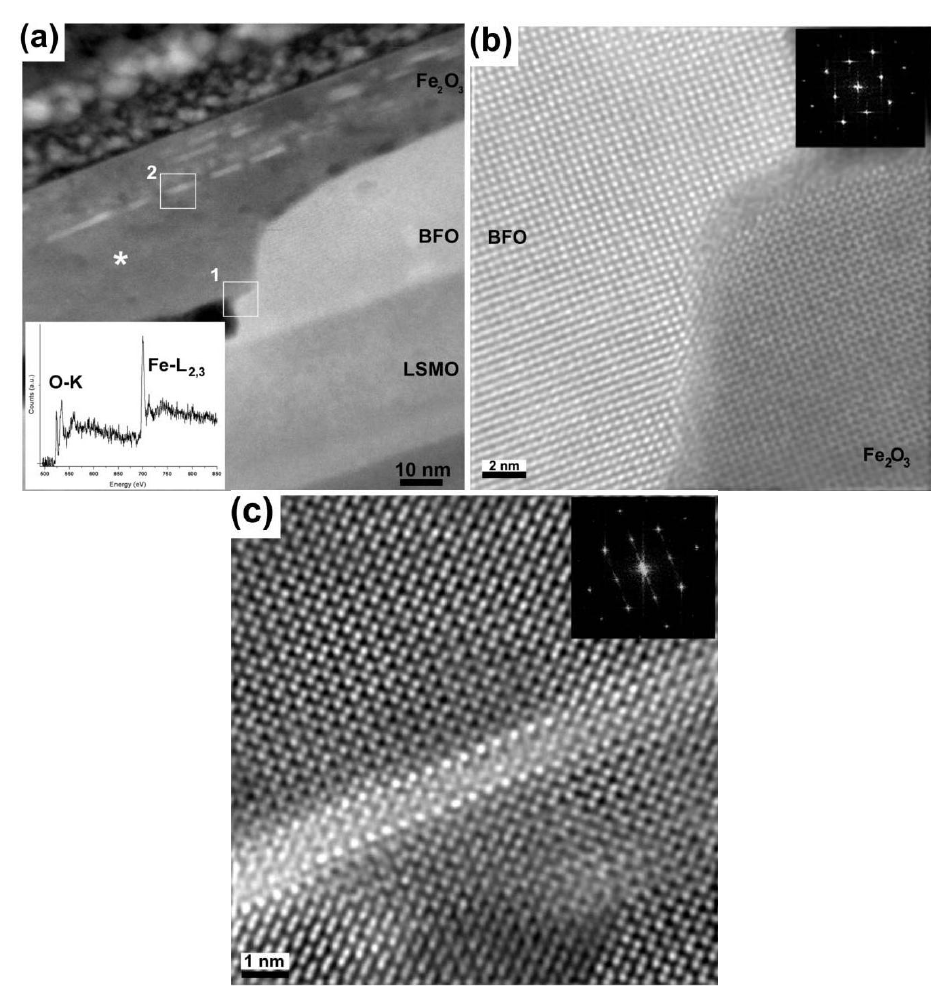
Figure 3. [001] Z-contrast images. (a) Overview showing the pocket area and the Fe BFO layer containing bright inclusions. Its inset contains an EEL spectrum from the area marked by the asterisk, confirming the presence of Fe; (b) Area marked as 1 in (a), showing the BFO and Fe O merger with their respective diffraction patterns as insets; 2 3 (c) Area marked as 2 in (a) with its corresponding diffraction pattern, showing an